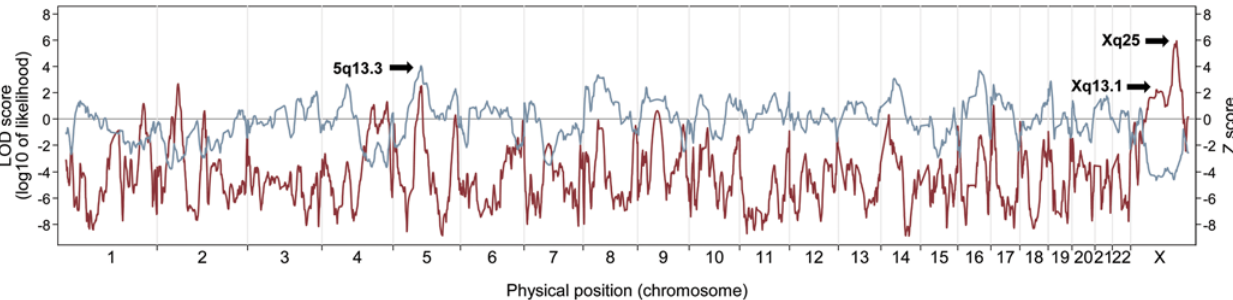
Figure 2. The dichotomous admixture scans for genetic loci affecting BMI. The locus-specific LOD score (red line) and the case-control Z score (blue gray line) are shown for Run 1 in Table 2: BMI was adjusted for age, age-squared, sex and studies. A signal at genome-wide significant level (locus-specific LOD=5.94) was detected at Xq25. The Xq25 peak was also supported by the case-control statistic (Z score= 2 3.94, P =8.1 6 10 2 5 ). Another peak on chromosome X was observed at Xq13.1 (locus-specific LOD=2.22). Although its LOD score did not reach statistical significance, it had the largest magnitude case-control Z score of 2 4.62 ( P =3.8 6 10 2 6 ) anywhere in the genome. Moreover, we observed an admixture signal at 5q13.3 (locus-specific LOD=2.48), which did not reach significance, but had the strongest positive case-control Z score across the genome (Z score=4.03, P =5.6 6 10 2 5 ).